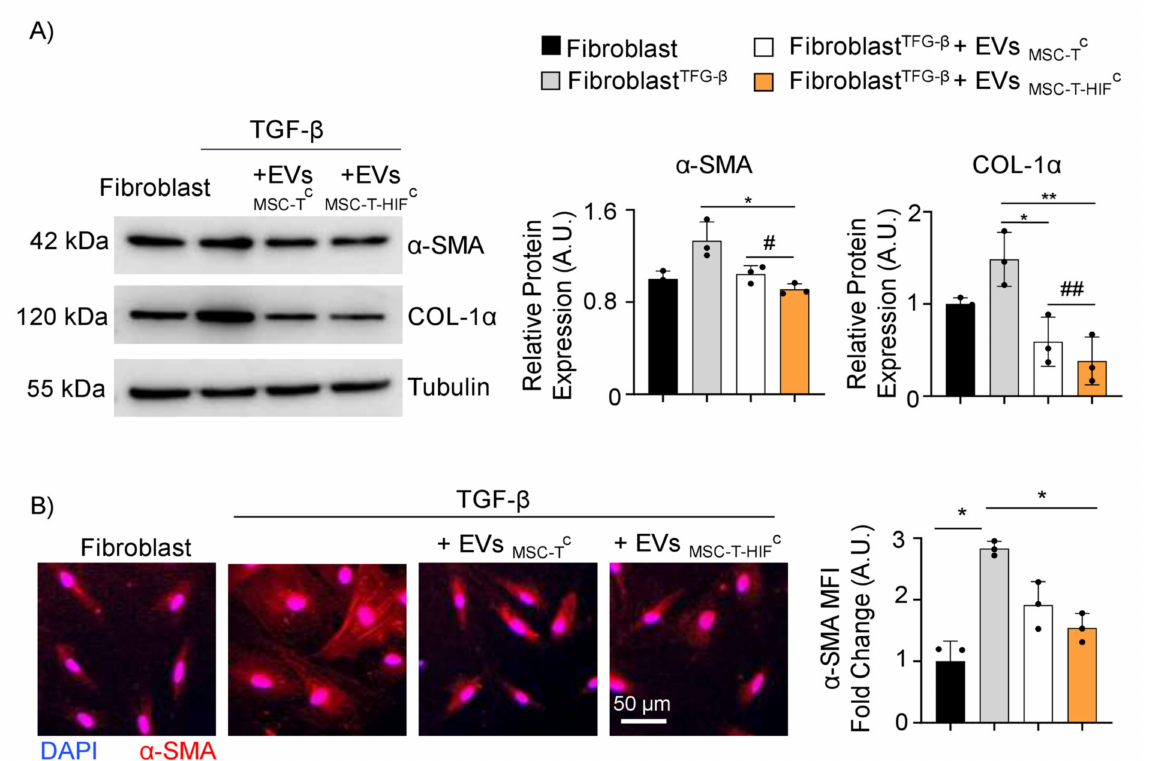
Figure 5. EV MSC-T-HIFC ameliorate fibrosis induced by TGF- β . ( A ) Representative Western blots of α -SMA and COL-1 α in unstimulated and TFG- β -stimulated dermal fibroblasts treated with EV MSC-TC or EV MSC-T-HIFC . Expression levels were quantified by densitometry relative to the levels in unstimulated fibroblasts. Tubulin was used as a loading control. Graphs represent the mean ± SD of three independent experiments. One-way ANOVA with Geisser–Greenhouse correction was used for statistical analysis. ( B ) Immunofluorescence of α -SMA (red) and nuclei staining (blue). Scale bar: 50 µ m. Bar graph shows quantification of red mean fluorescence intensity (MFI). Relative MFI was calculated by dividing all individual data by the MFI in unstimulated fibroblasts. Graph represents the mean ± SD of three independent experiments. One-way ANOVA with Geisser–Greenhouse correction was used for statistical analysis. * or # p < 0.05, ** or ## p <